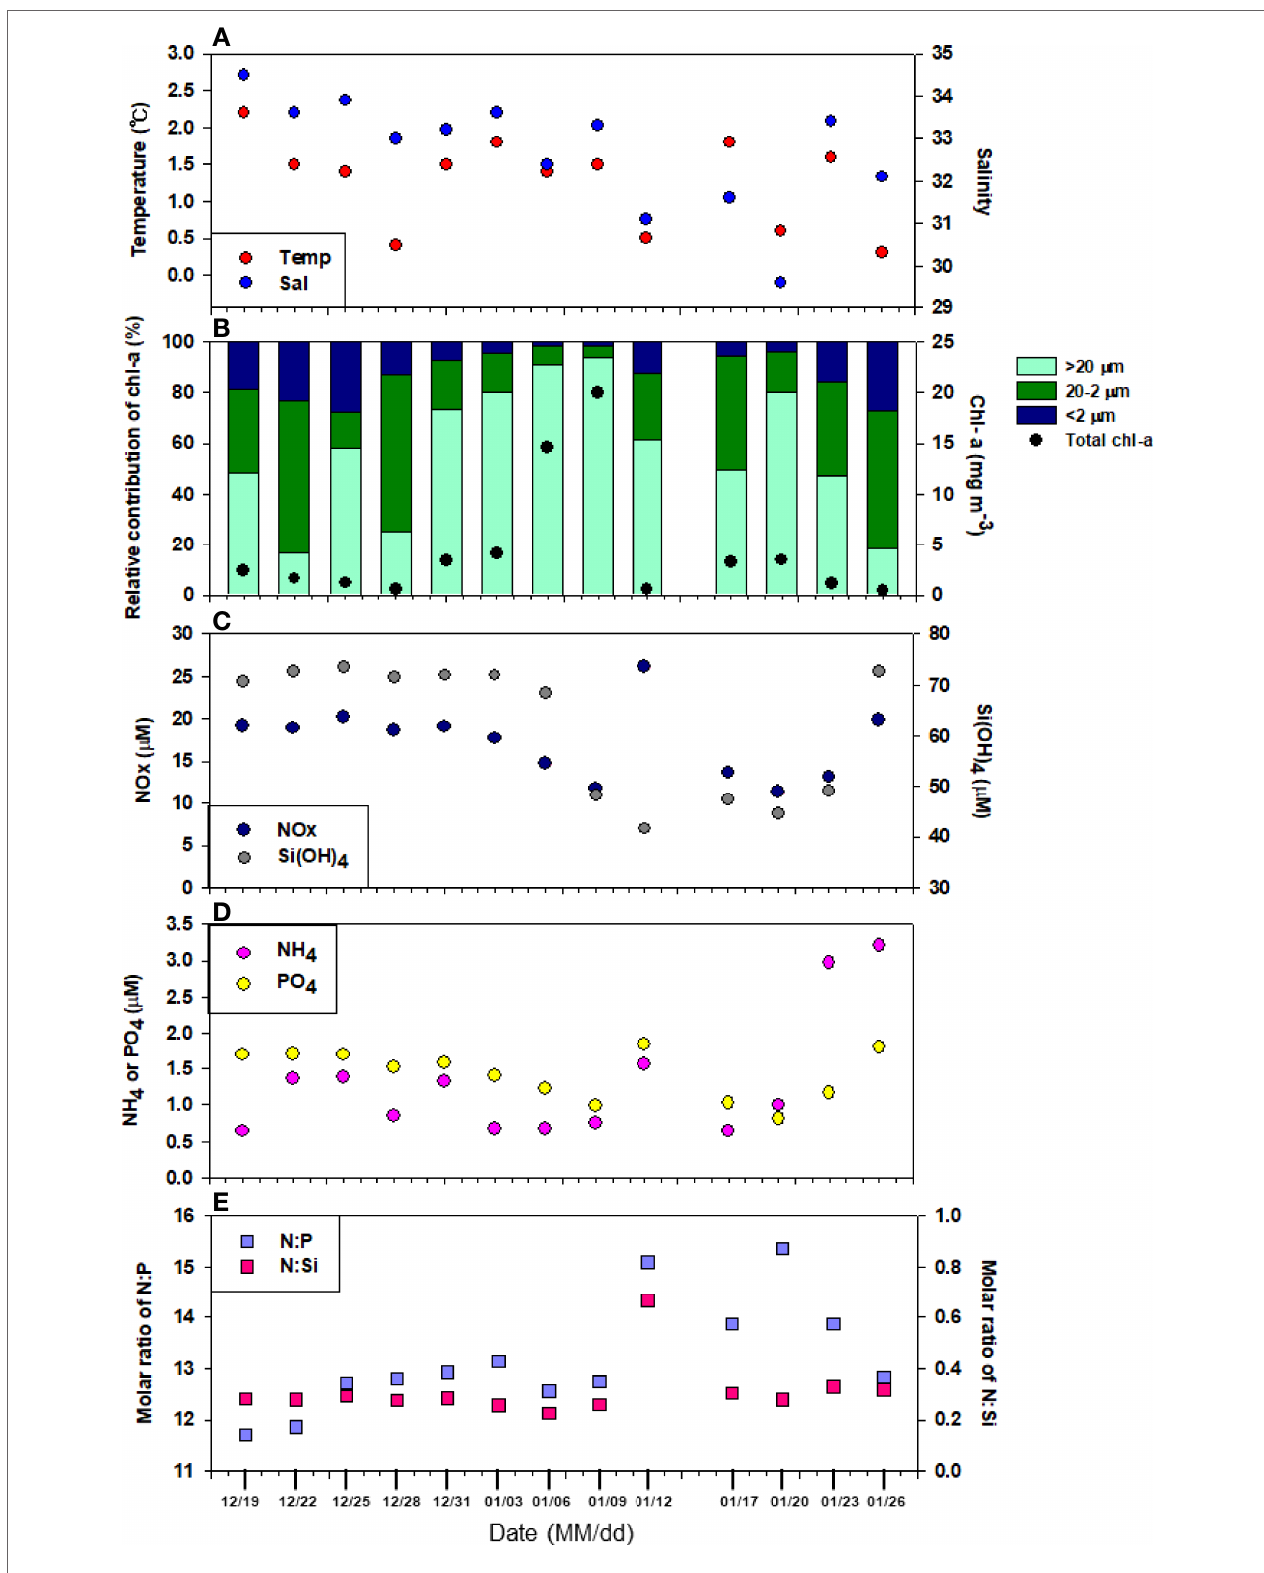
FIGURE 2 | Temporal variability of (A) water temperature and salinity, (B) total chlorophyll a concentration and percentage contribution of size-fractionated chlorophyll a, concentration of (C) NO x (NO 2- +NO 3- ) and SiO 2, (D) PO 43- and NH 4+ , (E) molar ratio of N:P and N:Si at surface water during sampling